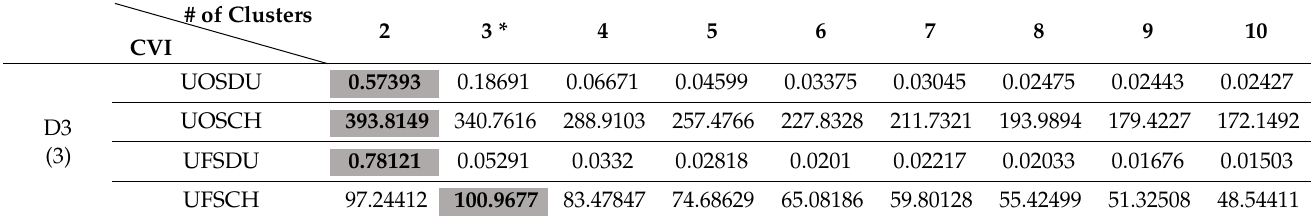
Table 4. Performance results for